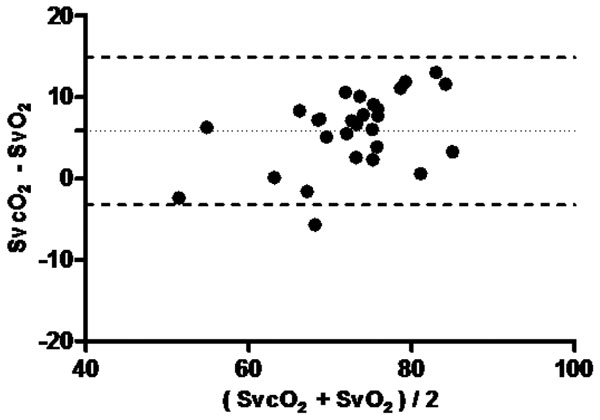
Bland-Altman (SvO2×SvcO2) in Group 2: bias 5.857, bias SD 4.627. 95% Limits of agreement: -3.211 to 14.93.